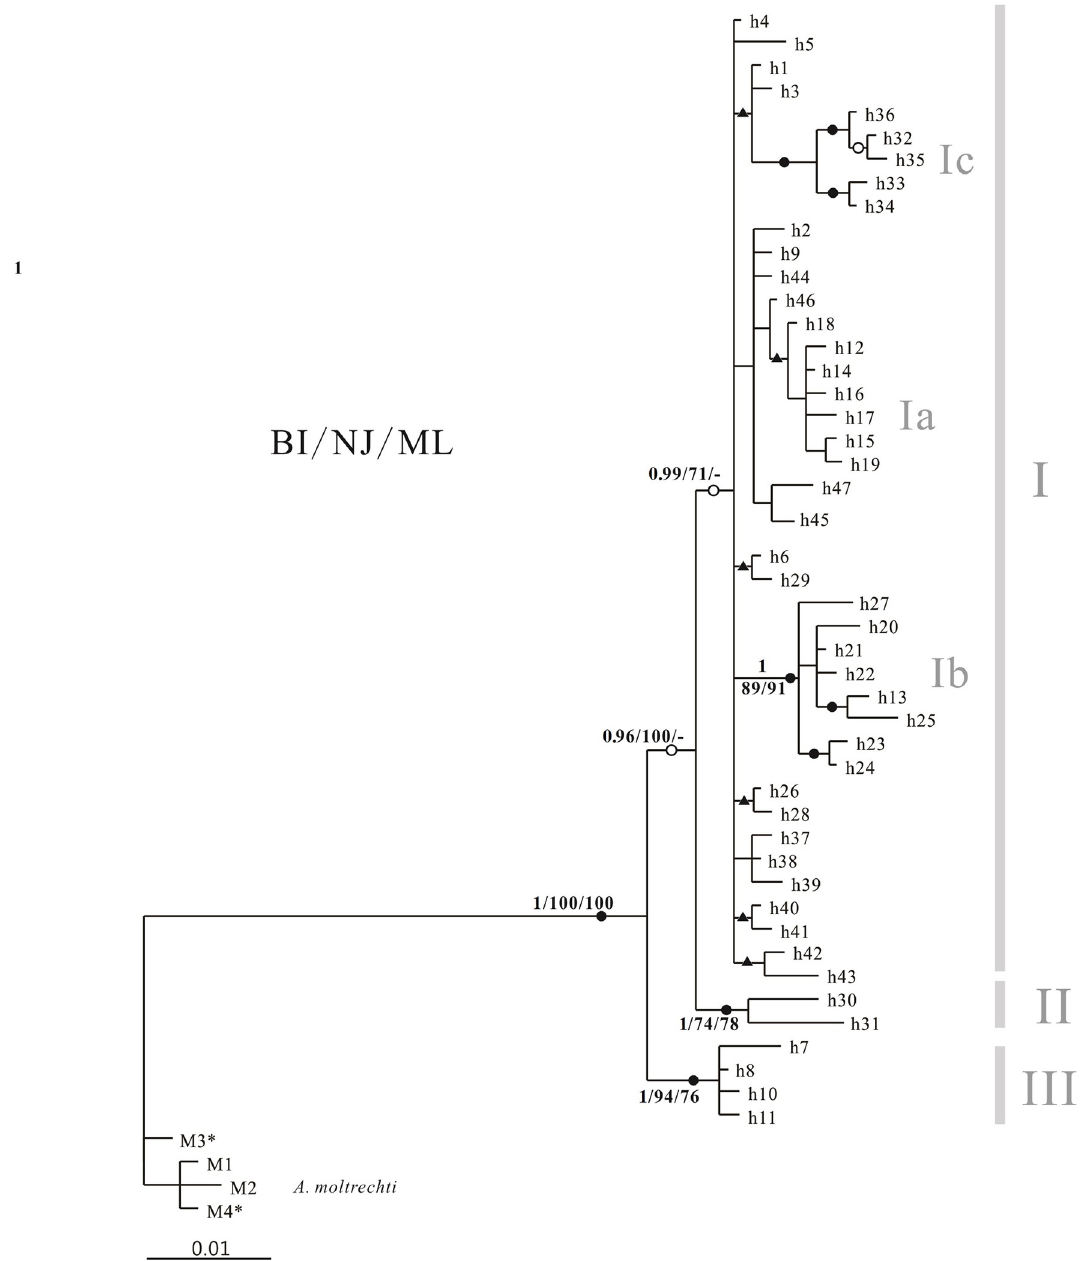
Fig 2. Bayesian tree of 1091-bp-long haplotypes inferred from partial cytb gene. Branch lengths are proportional to the scale given in nucleotide substitutions per site. Numbers at internal nodes are Bayesian inferences (only value > 0.90 are shown) and bootstrap values ( > 70%) for NJ and ML analyses. Only the values for major clades or sub-clades are shown. Solid circles at internal nodes indicate they were supported by all three analyses; open circles indicate they were supported by Bayesian and NJ analyses; and solid triangles indicate they were supported by Bayesian analysis only. Abbreviations beside clades or sub-clades correspond to the clades listed in Table 1. � indicates the haplotypes from the Zhoushui River, which were assigned to Aphyocypris amnis by Liao et al. [71]. River (site 9), the Wanlou River (site 10), and the Changhua River (sites 12–14), which were occupied by Clade III with four haplotypes from 11 individuals. Clade II was represented by two haplotypes (h30, h31) from three individuals collected from the Lou River (site A1), which